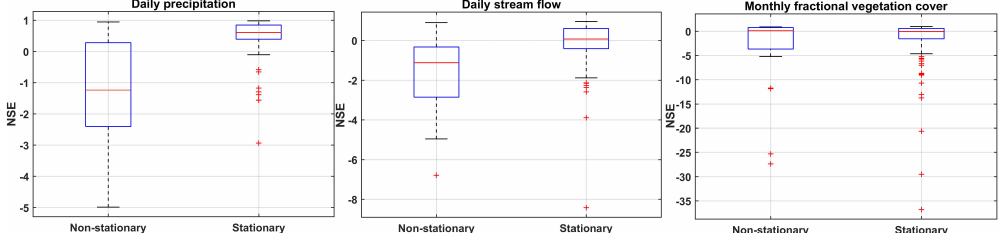
Figure 8. Box plots of Nash–Sutcliffe efficiency (NSE) values calculated between the regime curves of pre-drought and drought periods in catchments with non-stationary (20 catchments) and stationary (146 catchments) hydrologic response, respectively. Changes in daily precipitation and runoff and monthly fractional vegetation cover were larger in catchments with non-stationary hydrologic